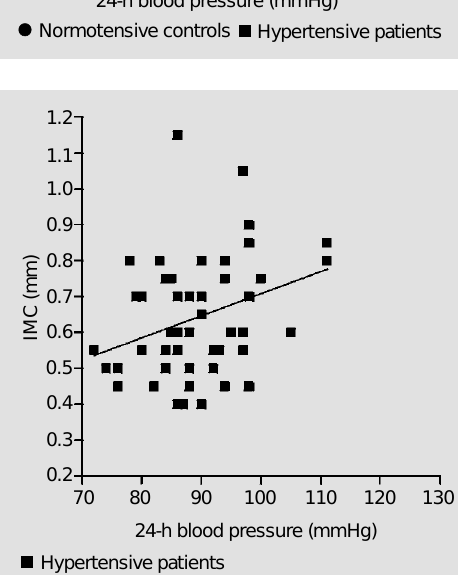
(0.0047 x 24-h SBP).